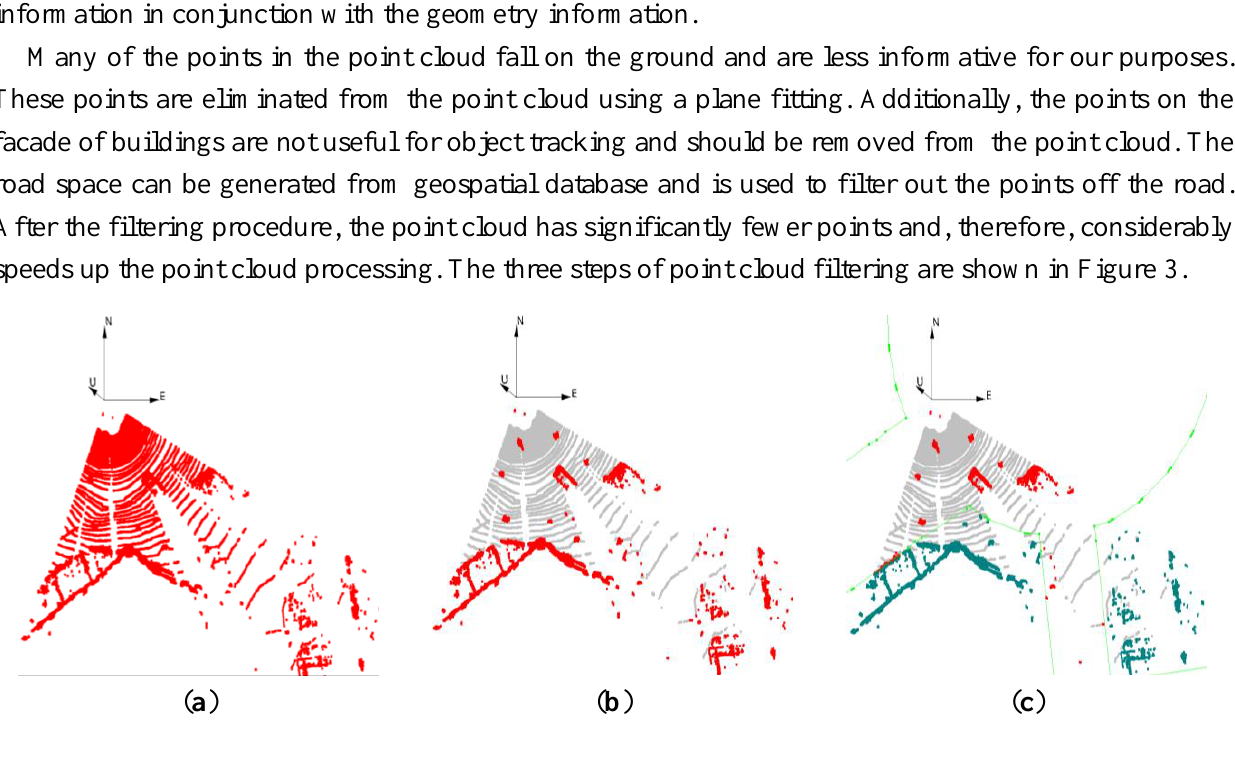
Figure 3. Point cloud filtering: ( a ) The forward point cloud is kept and the rest is removed from point cloud; ( b ) the points on the ground are eliminated (grey); ( c ) the points off the road are excluded (dark